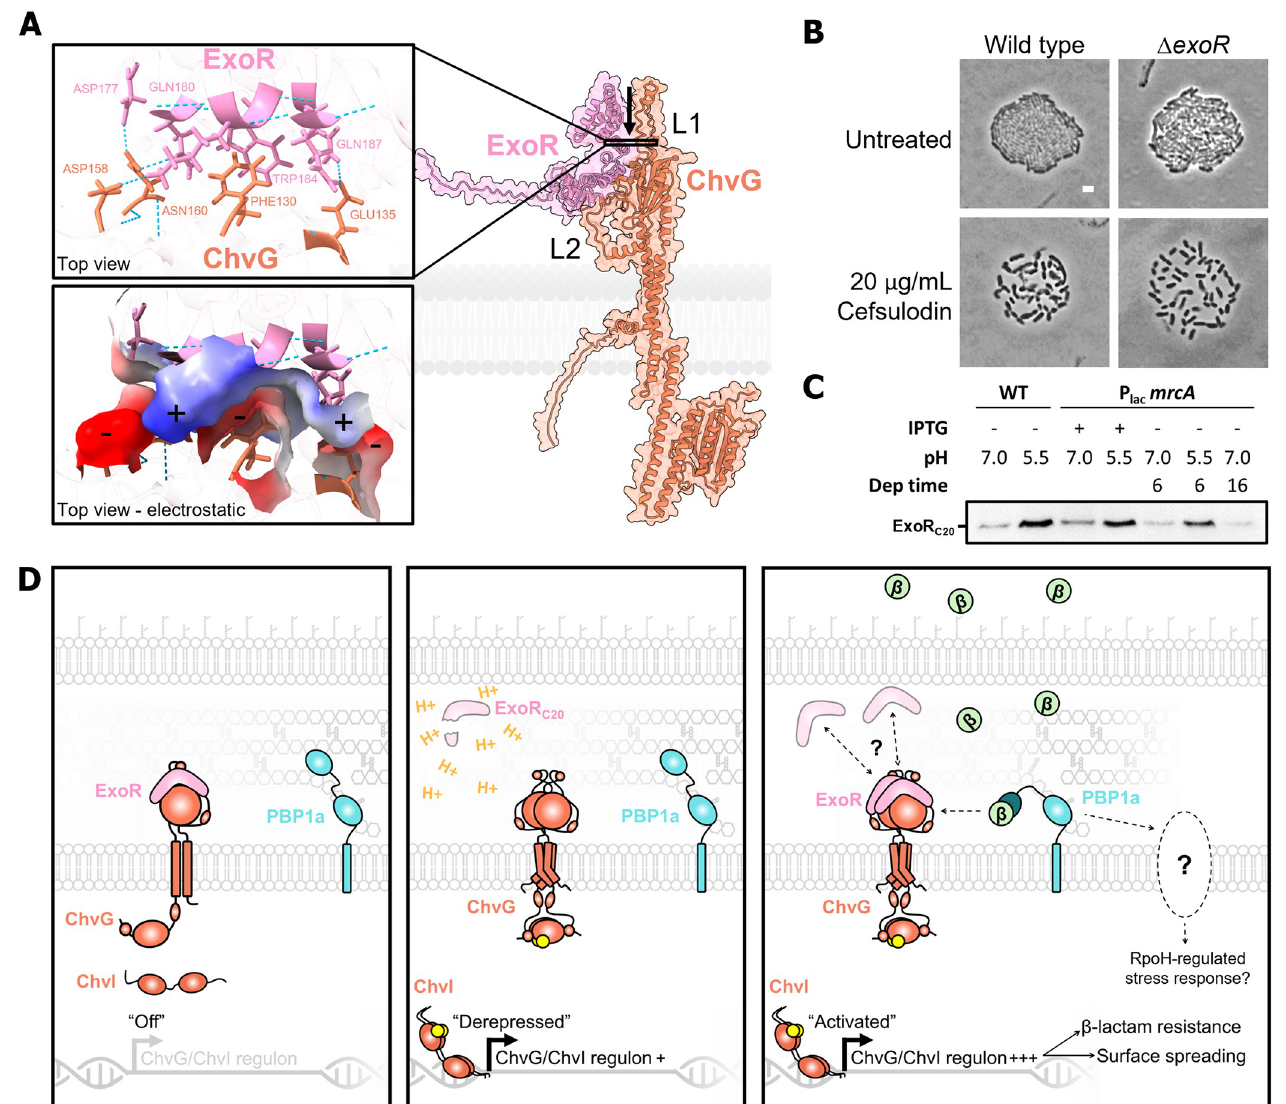
Fig 7. Activation of ChvG-ChvI can proceed independently of ExoR derepression. A. Predicted interaction site between ExoR and ChvG through AlphaFold-Multimer structure prediction. Insets show the top-down view of the interaction site with hydrogen bonding and electrostatic surface display. B. Microcolonies of wild type and Δ exoR with and without 20 μ g/mL cefsulodin treatment. C. Western blot detection of ExoR proteolysis (ExoR C20 ) with anti- FLAG against ExoR-FLAG. D. Working model of activation of ChvG-ChvI in A . tumefaciens . H + , free proton representing an acidic environment; β , β -lactam